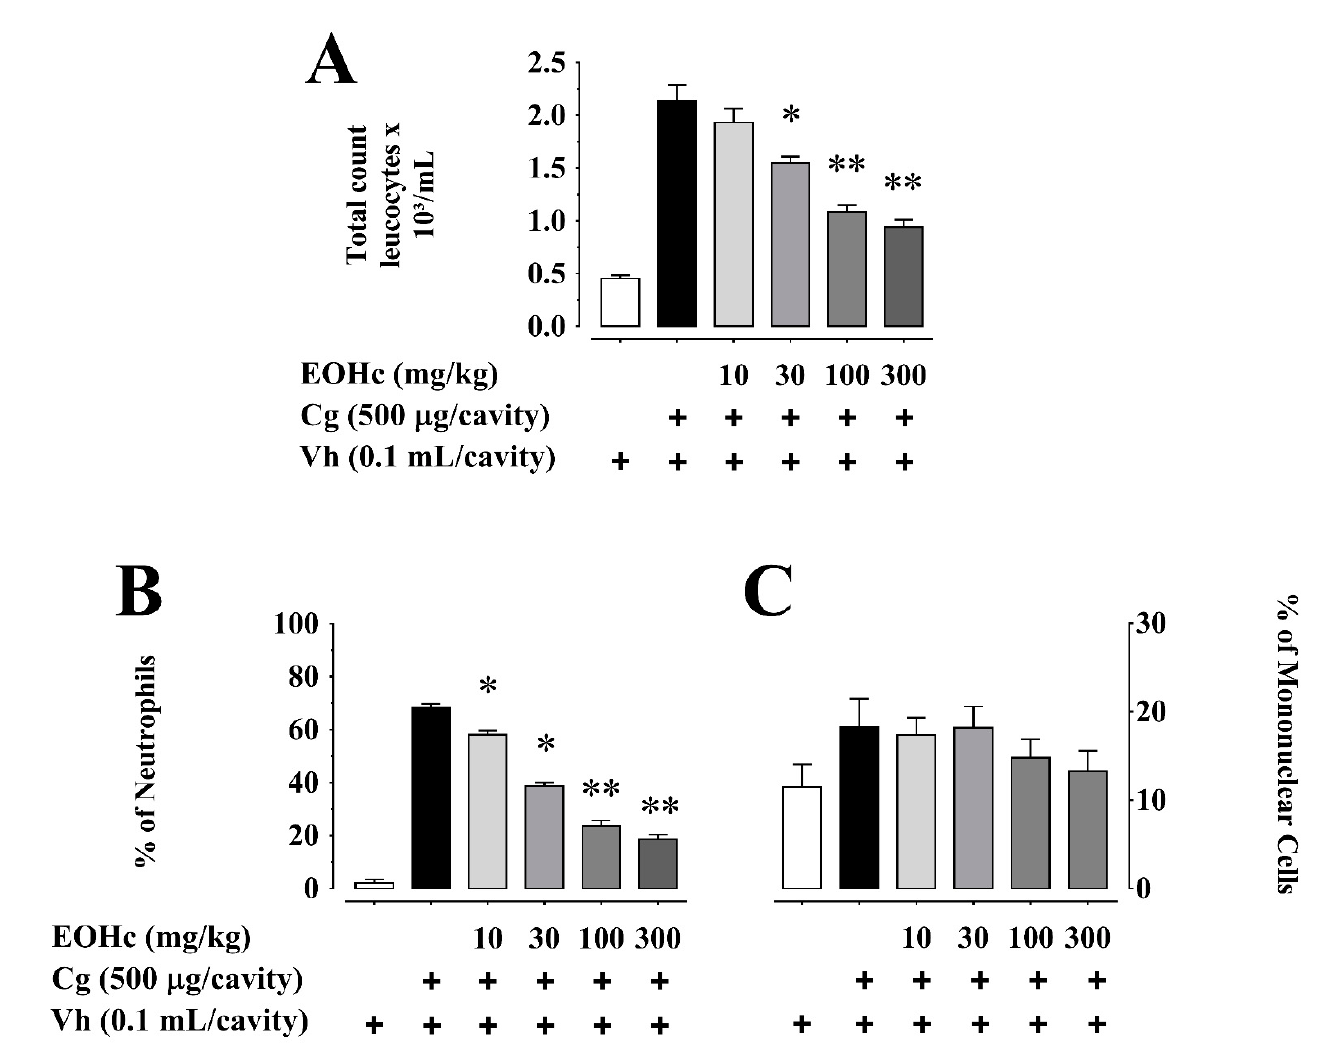
Figure 1. Inhibitory effects of essential oil of Hyptis crenata (EOHc) on peritonitis induced by carrageenan. EOHc (10–300 mg/kg) or the vehicle (0.1% Tween 80) was administered, orally, 1 h before induction of peritonitis with carrageenan (Cg, 500 µg/cavity) or of its vehicle (Vh, 0.9% NaCl solution, 0.1 mL/cavity). ( A ) Total number of leukocytes. ( B , C ) Number of neutrophils and mononuclear cells, respectively, expressed as percent of the total leukocytes (2.14 × 10 3 ± 0.14 × 10 3 /mL). *, p < 0.05; **, p < 0.01, vs. carrageenan (One-way ANOVA followed by Bonferroni’s test). n (number of animals) = 10 for all panels. “+” means in presence of. Table 1. EC 50 values of essential oil of Hyptis crenata on mediators of inflammation. (n 1 = 8–10).